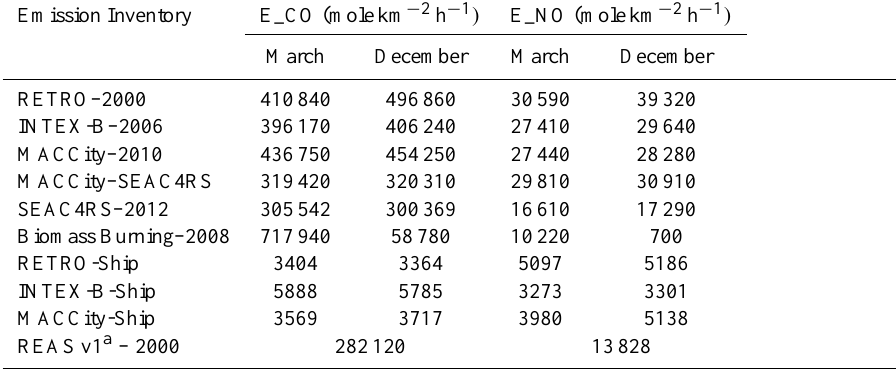
Table 2. Summation of CO emissions and NO emissions (molekm − 2 h − 1 ) from all grids in the model domain for each month. Emission